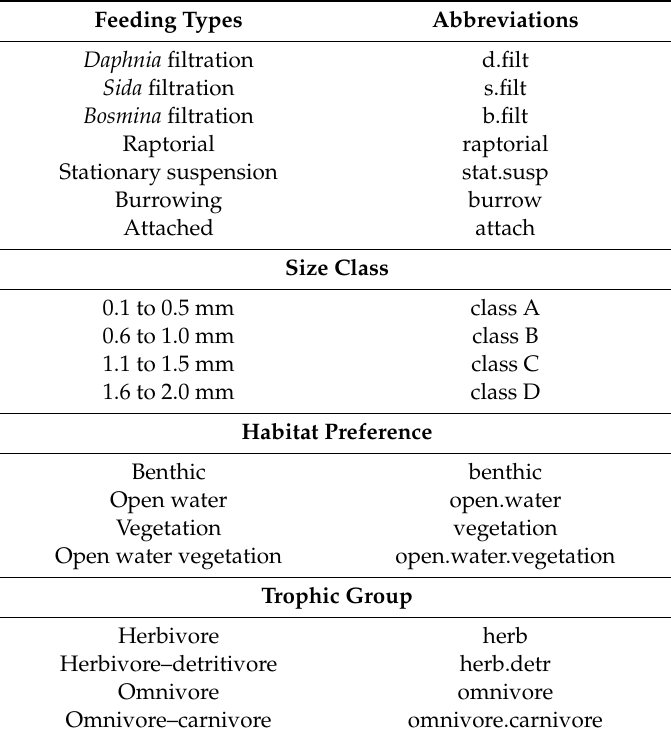
Table 1. Microcrustacean functional traits and their